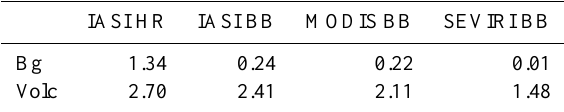
Table 3. Degrees of freedom (DOF) for the retrieval of the three aerosol parameters: N e , r e and H 2 SO 4 mixing ratio, with different instrumental configurations (IASI HR refers to the IASI high spec- tral resolution; IASI BB refers to IASI broadband features; MODIS BB refers to MODIS broadband features; SEVIRI BB refers to SE- VIRI broadband features. See the text for further details). DOF are calculated for typical background (Bg) and volcanic (Volc) condi- tions. IASI HR IASI BB MODIS BB SEVIRI BB Bg 1.34 0.24 0.22 0.01 Volc 2.70 2.41 2.11